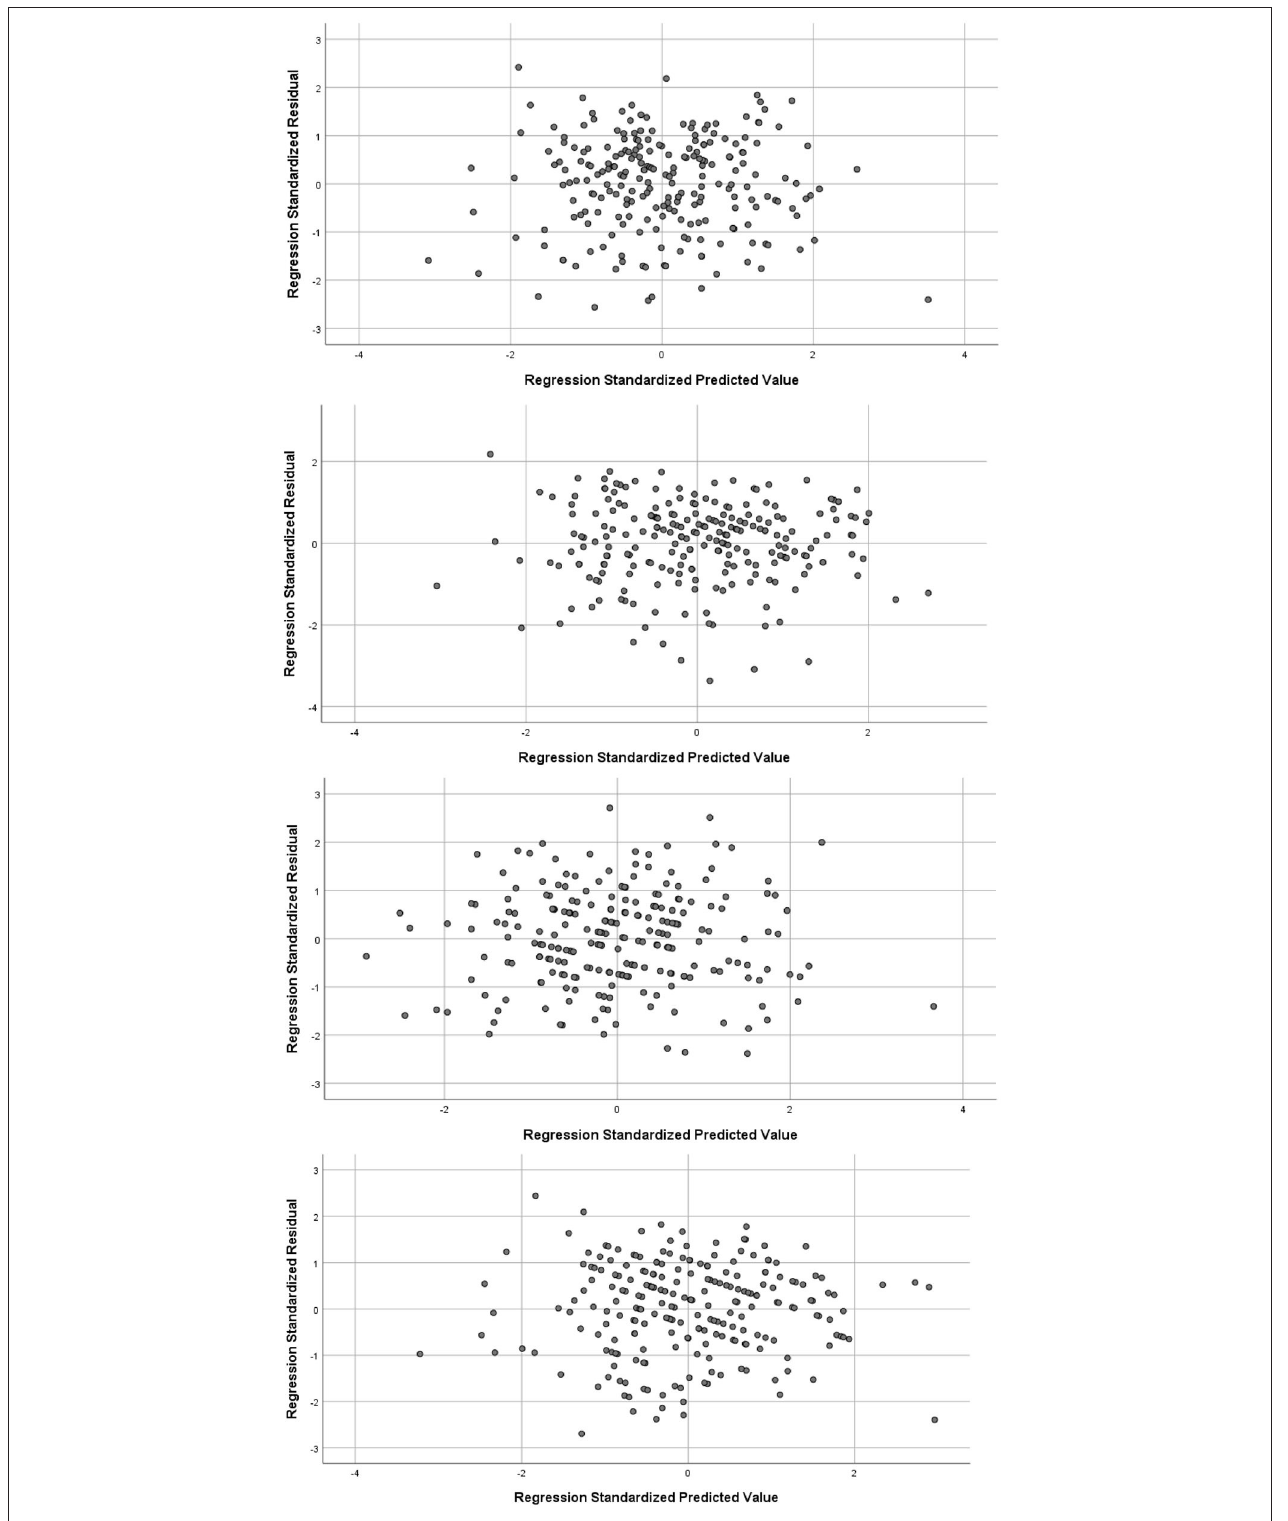
FIGURE 2 | Tests of homoscedasticity with scatterplots of regression standardized residuals where the DVs are: Total (top), DDF (seconds from top), DIF (second from bottom), EOT (bottom).